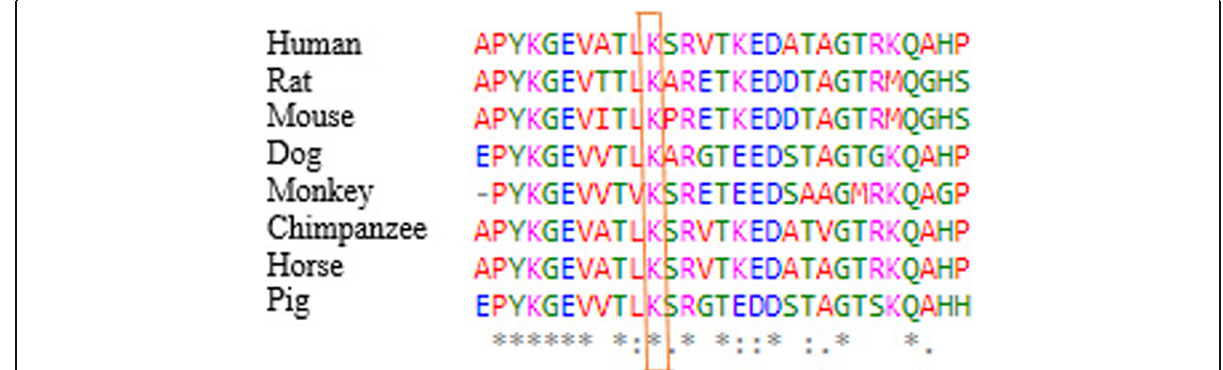
Fig. 2 Comparative amino acids alignment of DPYS protein across mammals shows that the Lys501 residue is highly conserved during evolution. The conserved Lys (K) residue is shown in the rectangular box. National Center for Biotechnology was used to obtain protein sequences. Symbols (*) and (:) shows identical amino acids and just similar amino acids respectively